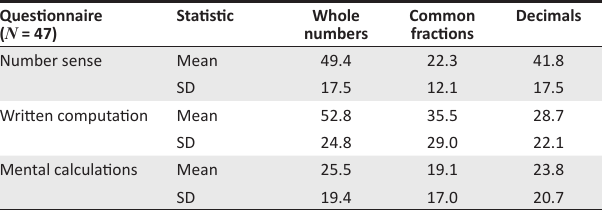
TABLE 1: Descriptive statistics for the number sense questionnaire, written computation questionnaire and mental calculations questionnaire by number domain ( %